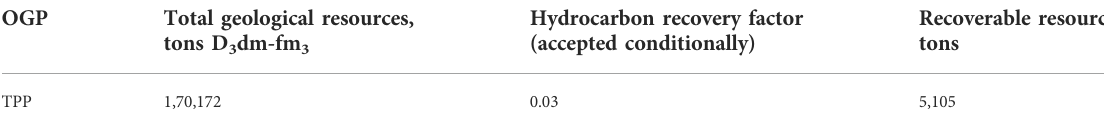
TABLE 8 Estimation of resources in the high-carbon shale layer of the Domanik of the TPP (Varlamov et al., 2020; Fortunatova et al., 2021).